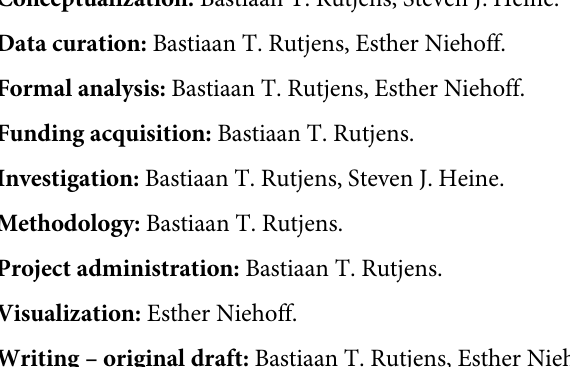
S2 Table. Zero-order correlations of variables introduced in Study 1. S3 Table. Cronbach Alpha’s and Pearson correlations for generated scales in Study 2. S4 Table. Zero-order correlations of variables introduced in Study